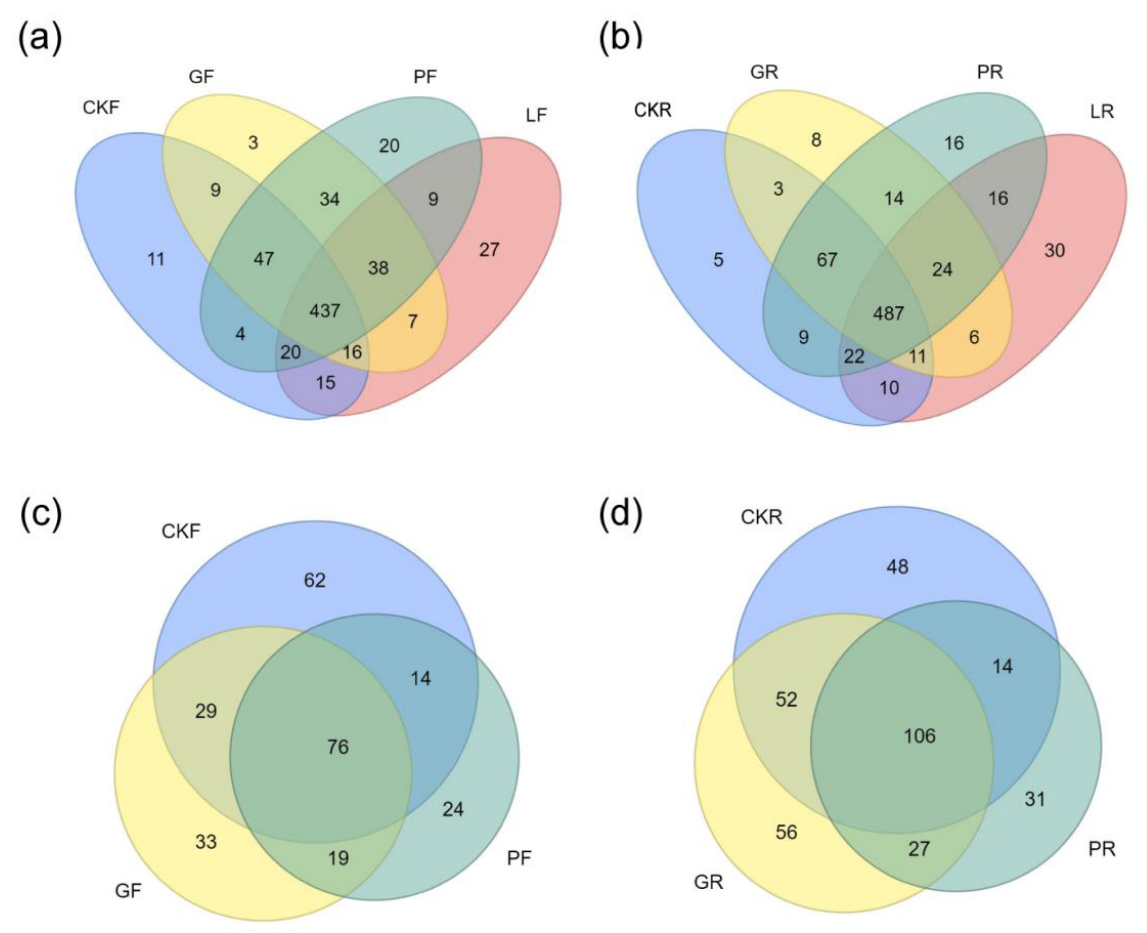
Figure 2. The OTU number of bacteria and fungi in different treatment groups. ( a ) Bacteria OTUs in feces, ( b ) Bacteria OTUs in rumen, ( c ) Fungal OTUs in feces, ( d ) Fungal OTUs in rumen. R: rumen samples, F: feces samples.